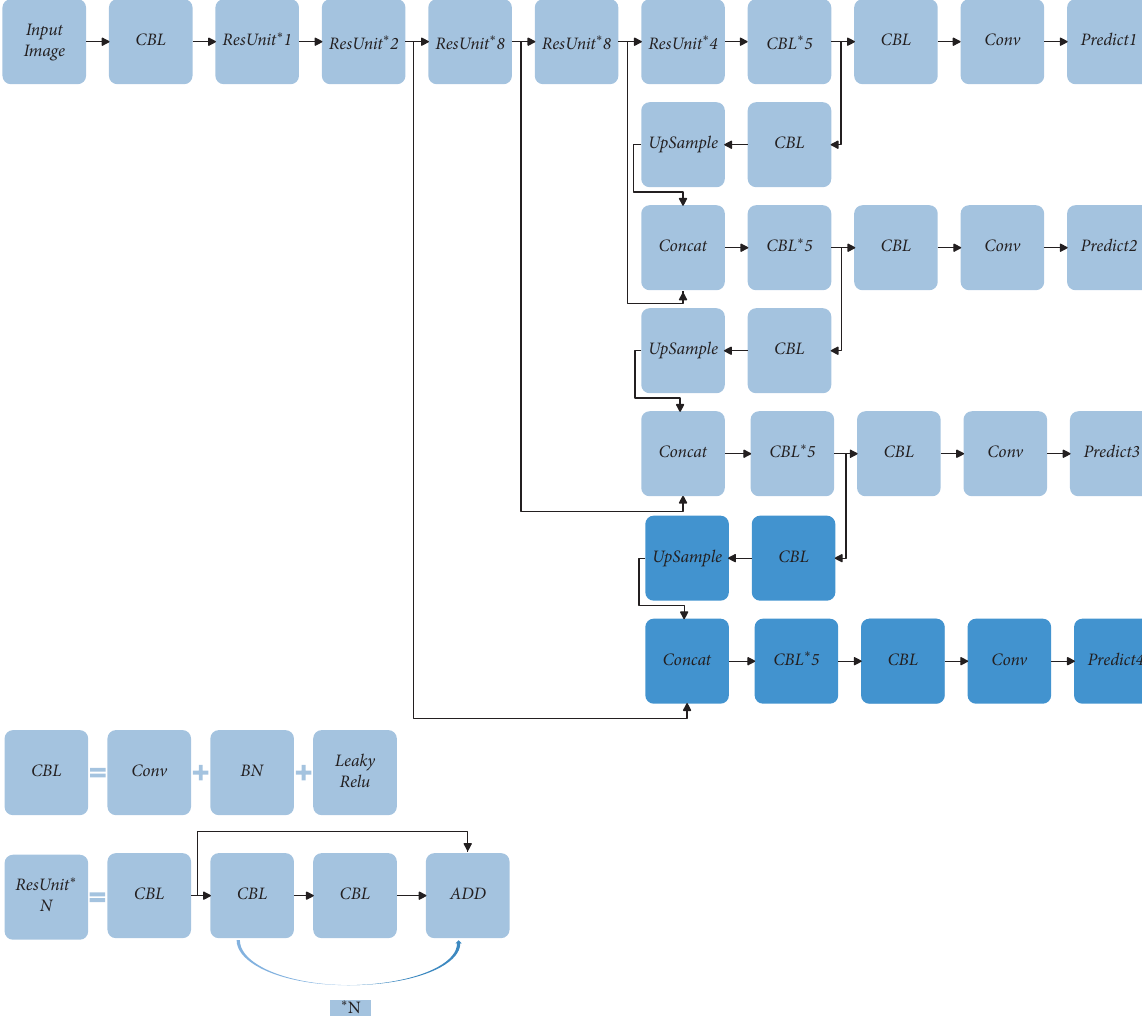
Figure 7: MSDN network